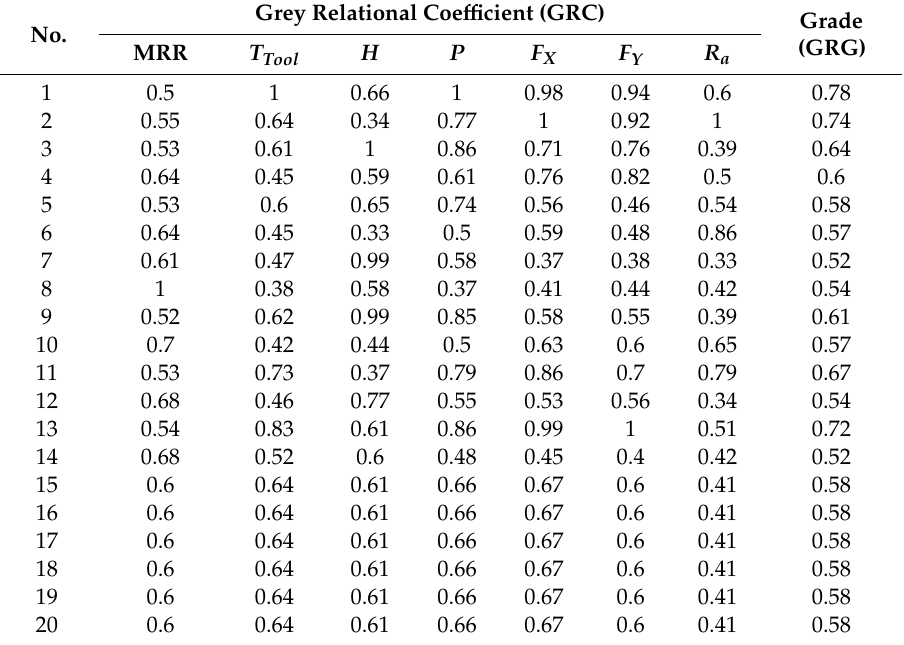
Table 7. GRG for Trial